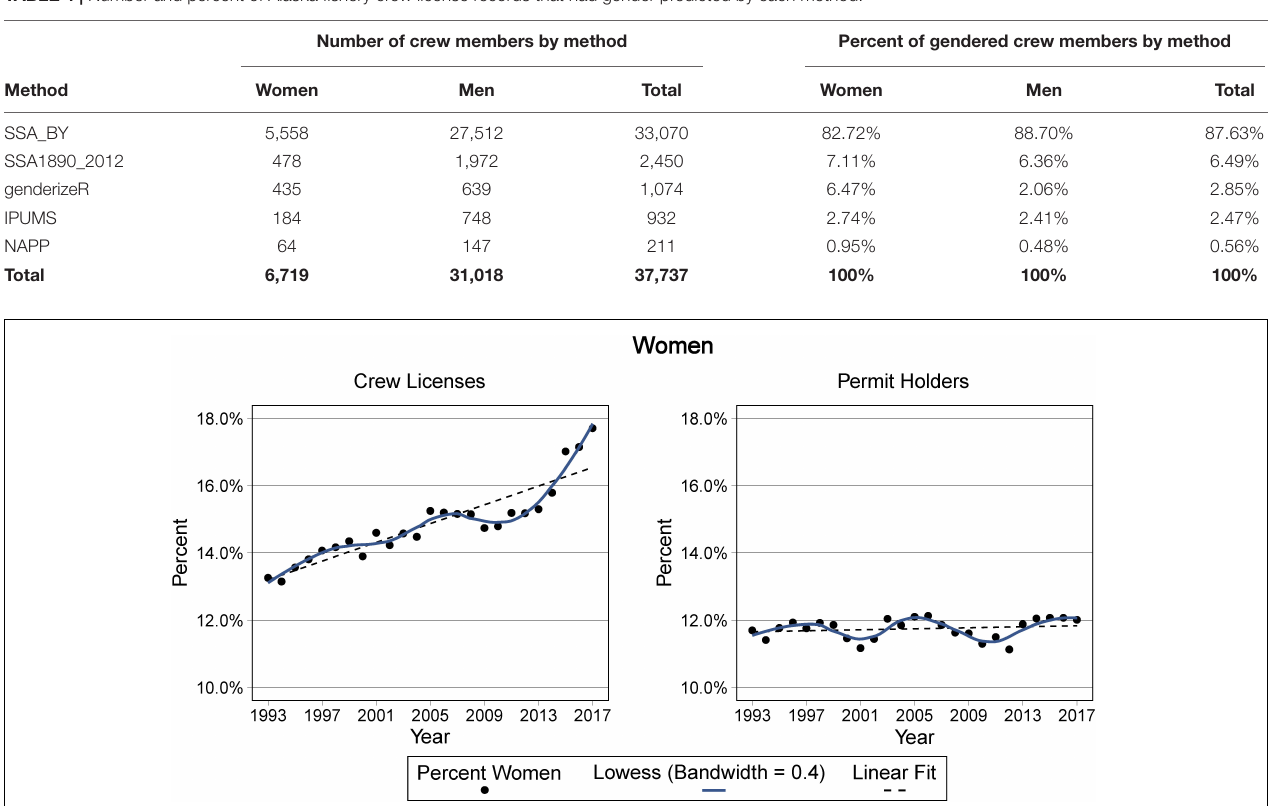
TABLE 4 | Number and percent of Alaska fishery crew license records that had gender predicted by each method. Number of crew members by method Percent of gendered crew members by method